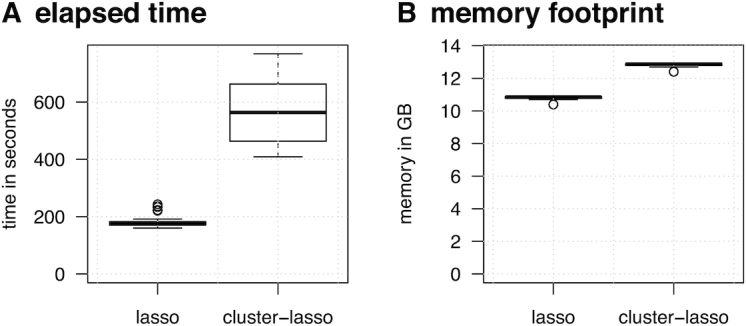
Time and memory requirements. The box plots represent the variability of the time in seconds (A) and maximum memory in gigabytes (GB) (B) required to generate a lasso or cluster-lasso regularization path for the 10 antibiotics.